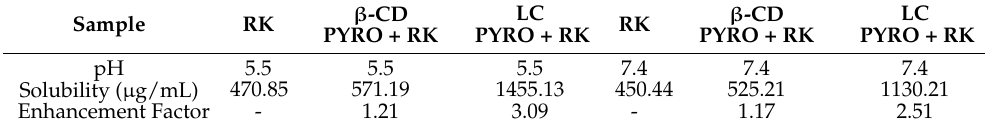
Table 3. Saturation solubility studies of the formulations with their enhancement factors.